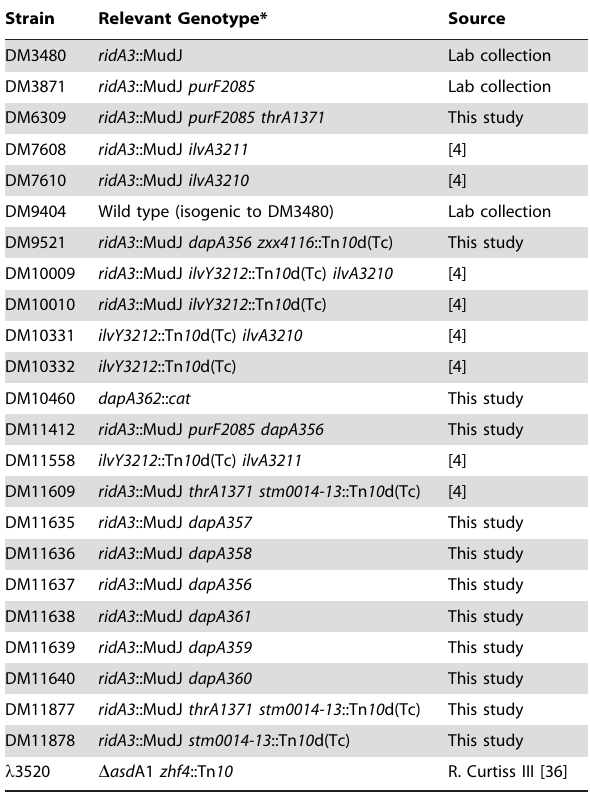
Table 1. Bacterial